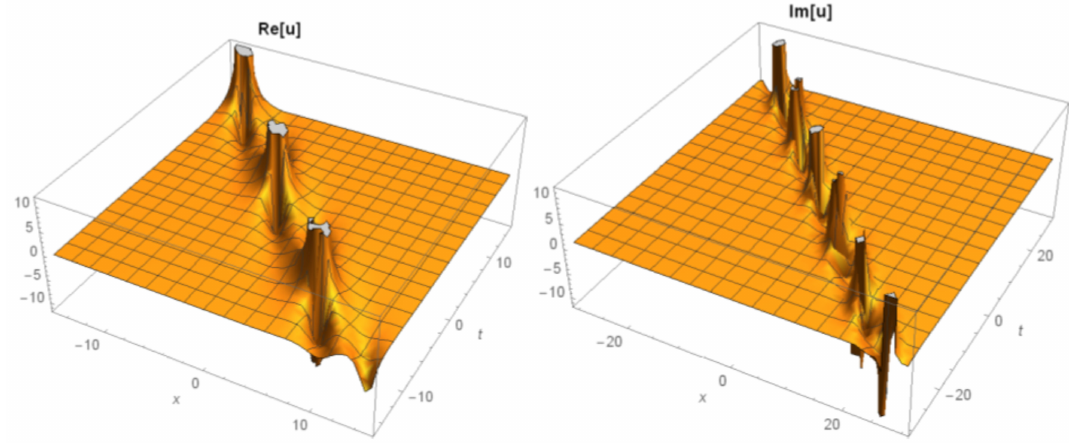
Figure 8. The 3D surfaces of Equation (22) under the values of ε = 0.4, − 15 < x < 15, − 15 < t < 15.